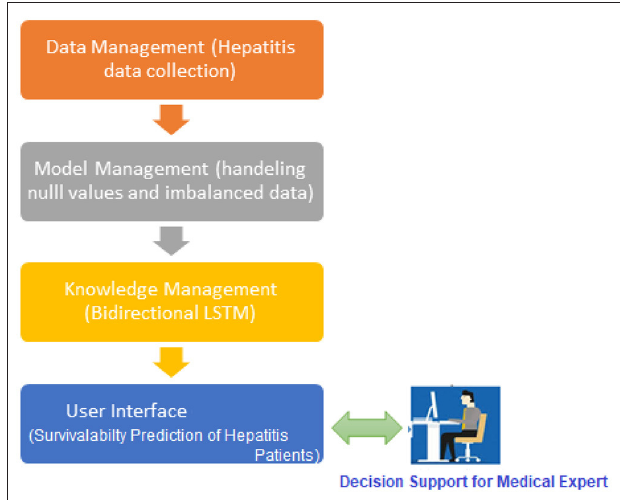
FIGURE 1 | A preview of the proposed hepatitis disease prediction